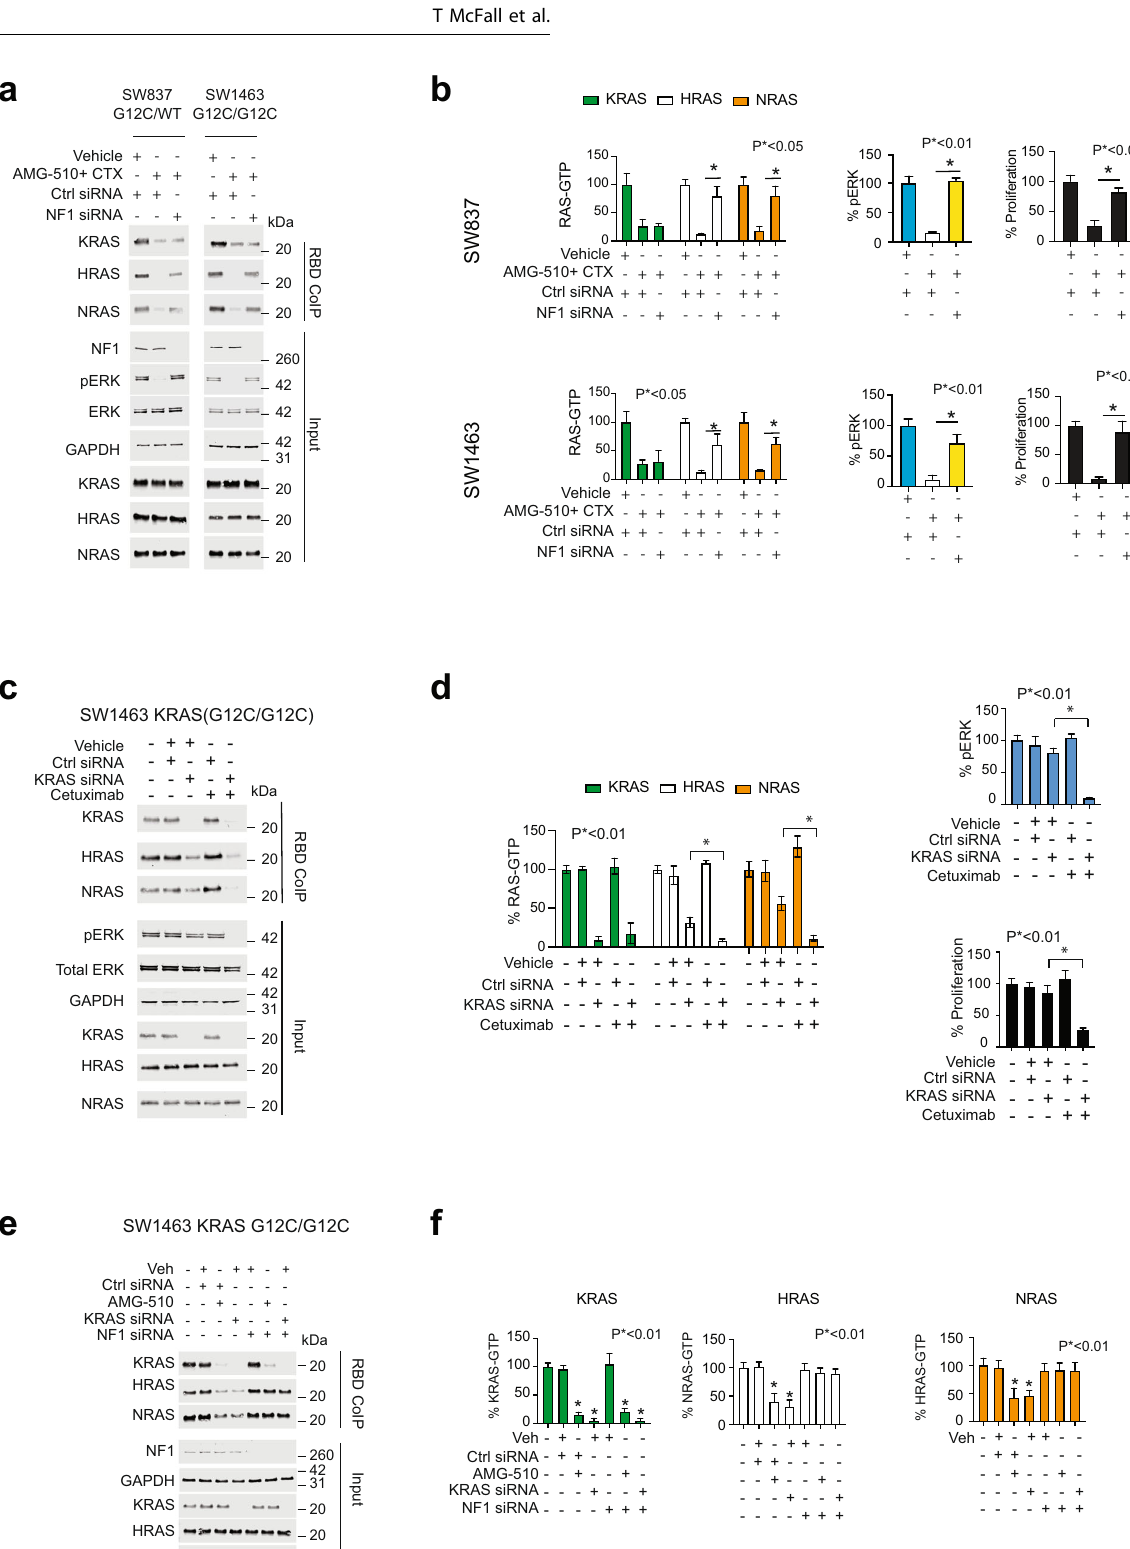
Two processes have previously been demonstrated to contribute to the bene fi ts of co-targeting KRAS G12C and EGFR: increased loading of the G12C inhibitor and targeting EGFR after negative feedback pathways are released. Our work presents a third bene fi t of this combination: combined